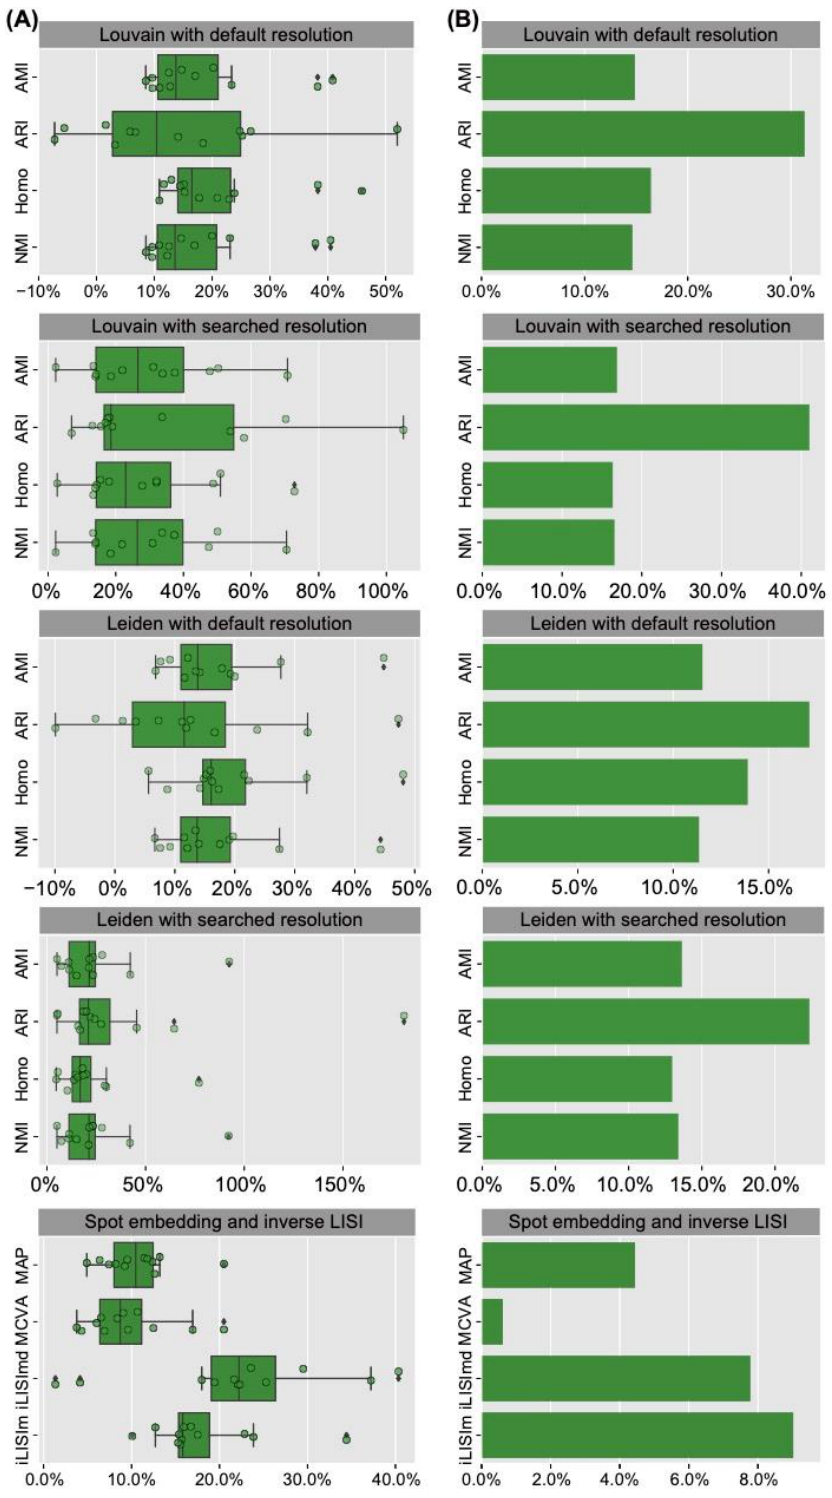
Figure 7. Performance improvement of STAGATE using SINFONIA on ( A ) the 12 DLPFC datasets and ( B ) the MBC dataset. The performance of spatial clustering, domain resolution and prediction ability were evaluated.